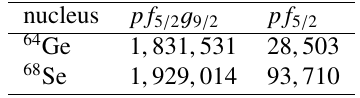
Table 1. The dimensions of the model spaces pf 5 / 2 g 9 / 2 and pf 5 / 2 used in our calculations (illustrated in terms of the number of basis states for the projection M J = 0 of the total angular momentum J ) for the nuclei 64 Ge and 68 Se.